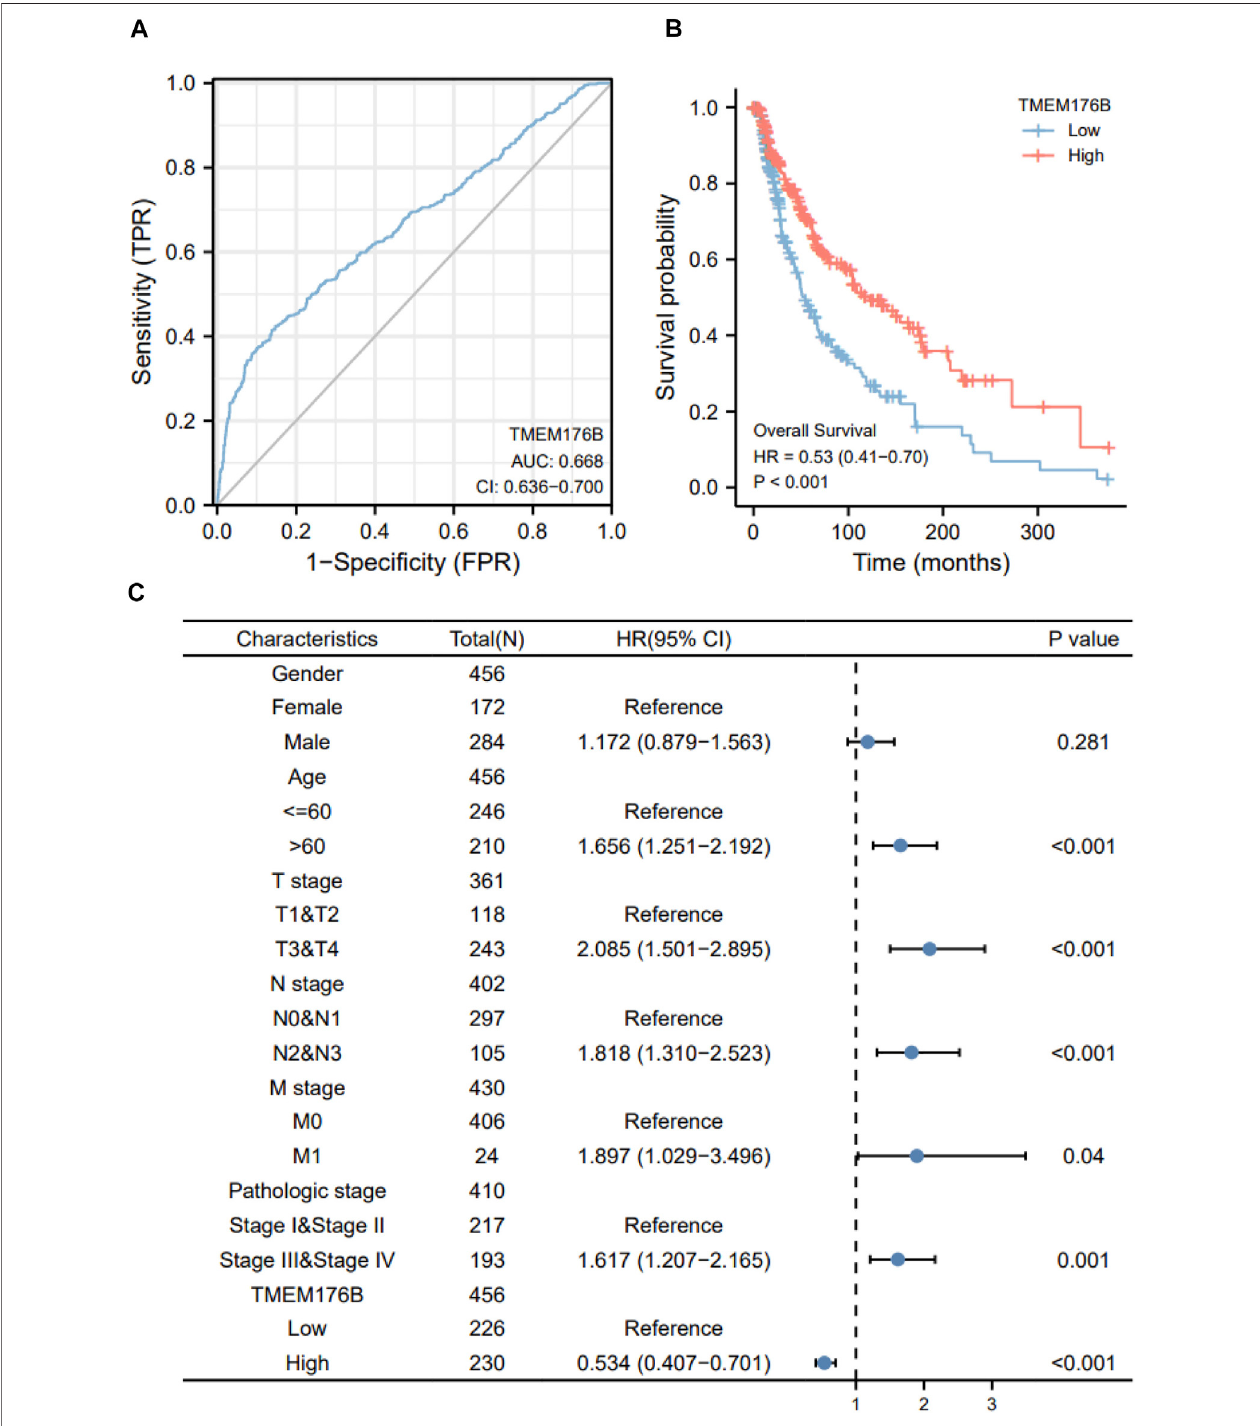
FIGURE2| Theprognosticvalueof TMEM176B . (A) ROCanalysisshowedthat TMEM176B wasabletoidentifytumorand normaltissue,theAUCwas0.668. (B) SurvivalevaluationindicatorsOS, via theexpressionlevelofthe TMEM176B geneinSKCM. (C) UnivariateCoxregressionanalysisof TMEM176B andclinicopathological variables with OS in SKCM.